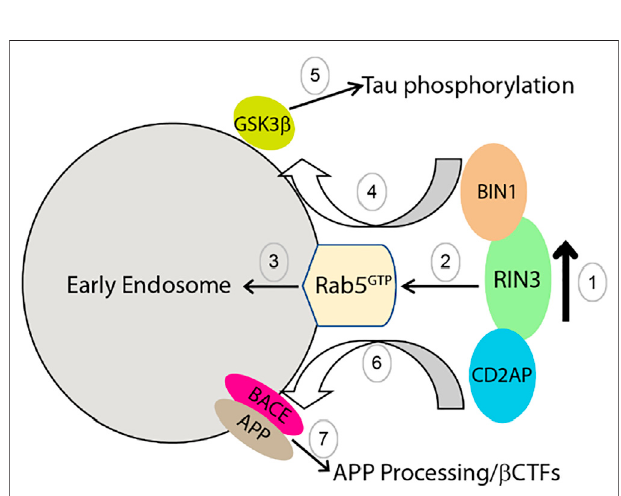
FIGURE 6 | Proposed mechanism by which increased RIN3 activity leads to tau phosphorylation and amyloidic processing of APP in AD.